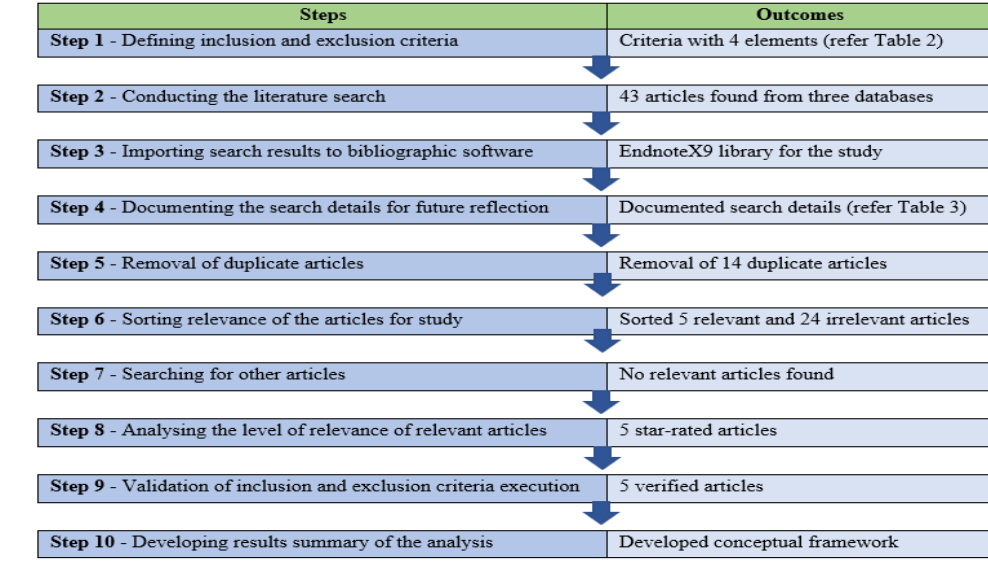
Figure 3. Adapted procedure for scoping review (Source: Author developed based on O’Brien and Guckin [84]).